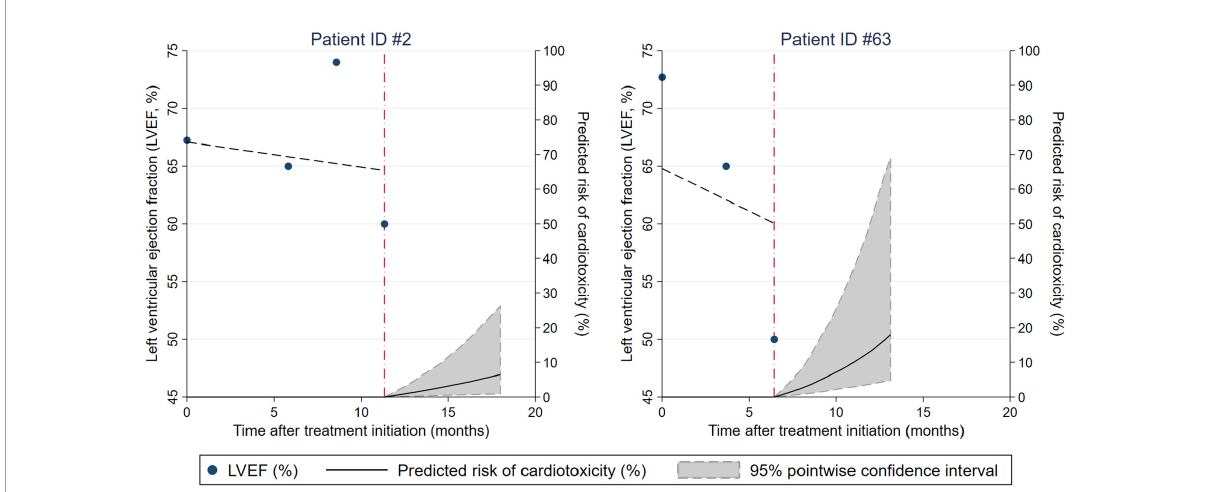
FIGURE3 Dynamic prediction of cardiotoxicity risk for individual patients conditional on their prior left ventricular ejection fraction (LVEF) trajectory. Results are from a joint model of longitudinal and time-to-event data. The characteristics of patients ID#2 and ID#63 are described in the Results section, paragraph “Personalized prediction of cardiotoxicity risk based on LVEF trajectories.”